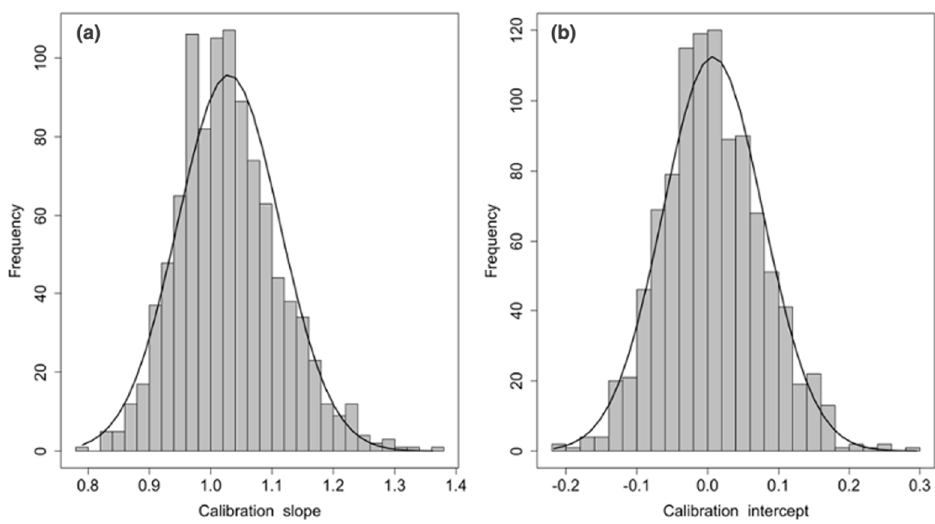
Figure 5 . CFZ CVAEs Risk Score Calibration: ( a ) calibration slope and ( b ) calibration intercepts.